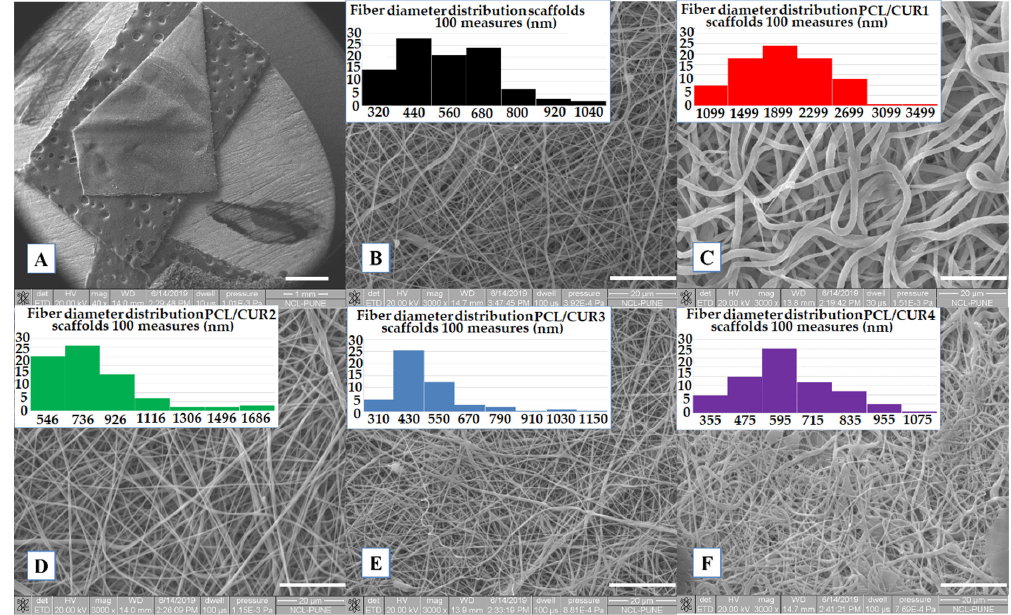
Figure 2. SEM images of PCL/CUR scaffolds. ( A ) General view of the membranes (1×), ( B ) PCLc, ( C ) PCL/CUR1, ( D ) PCL/CUR2, ( E ) PCL/CUR3, ( F ) PCL/CUR4. Images B–F have 3000× of amplification.